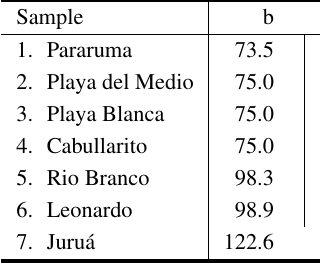
(Table III) makes excellent geographic sense: